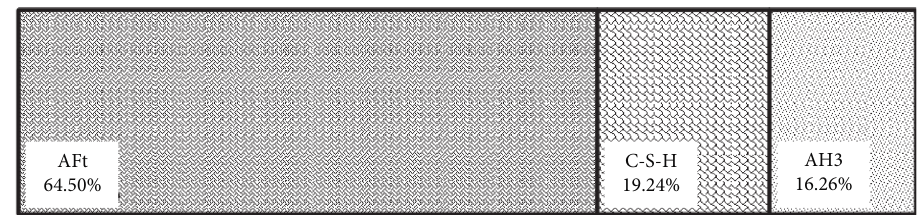
Figure 5: Mass component of solid-phase in of NCG concretion.